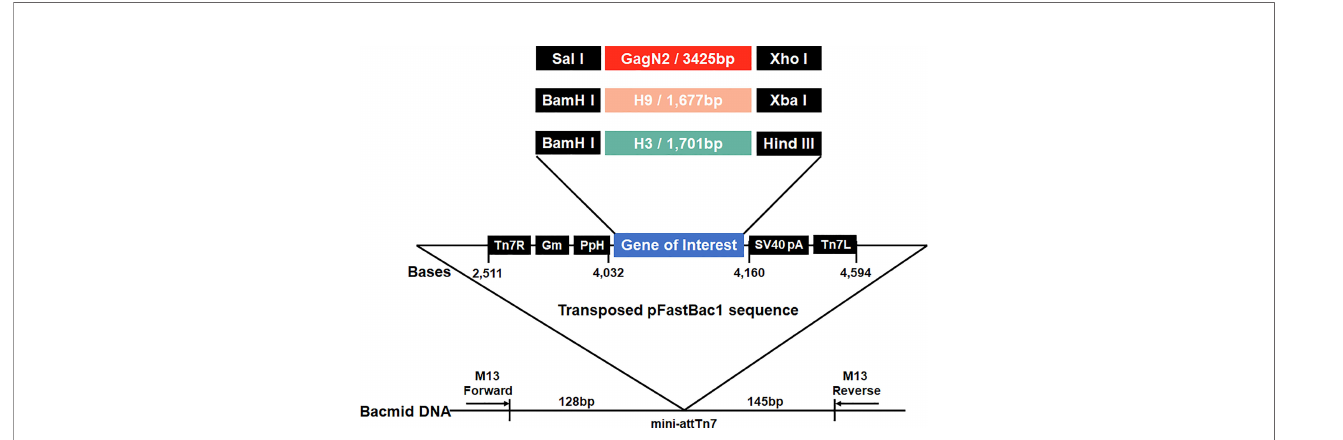
FIGURE 1 | Schematic construction map of three recombinant bacmids. Three expression cassettes harboring the GagN2, H9 or H3 genes limited by Tn7R and Tn7L in the pFastBac1 plasmids will be transposed into the bacmids, respectively. Black arrows show M13 forward and reverse primers used for the PCR analysis of three recombinant bacmids. The diagram is not to